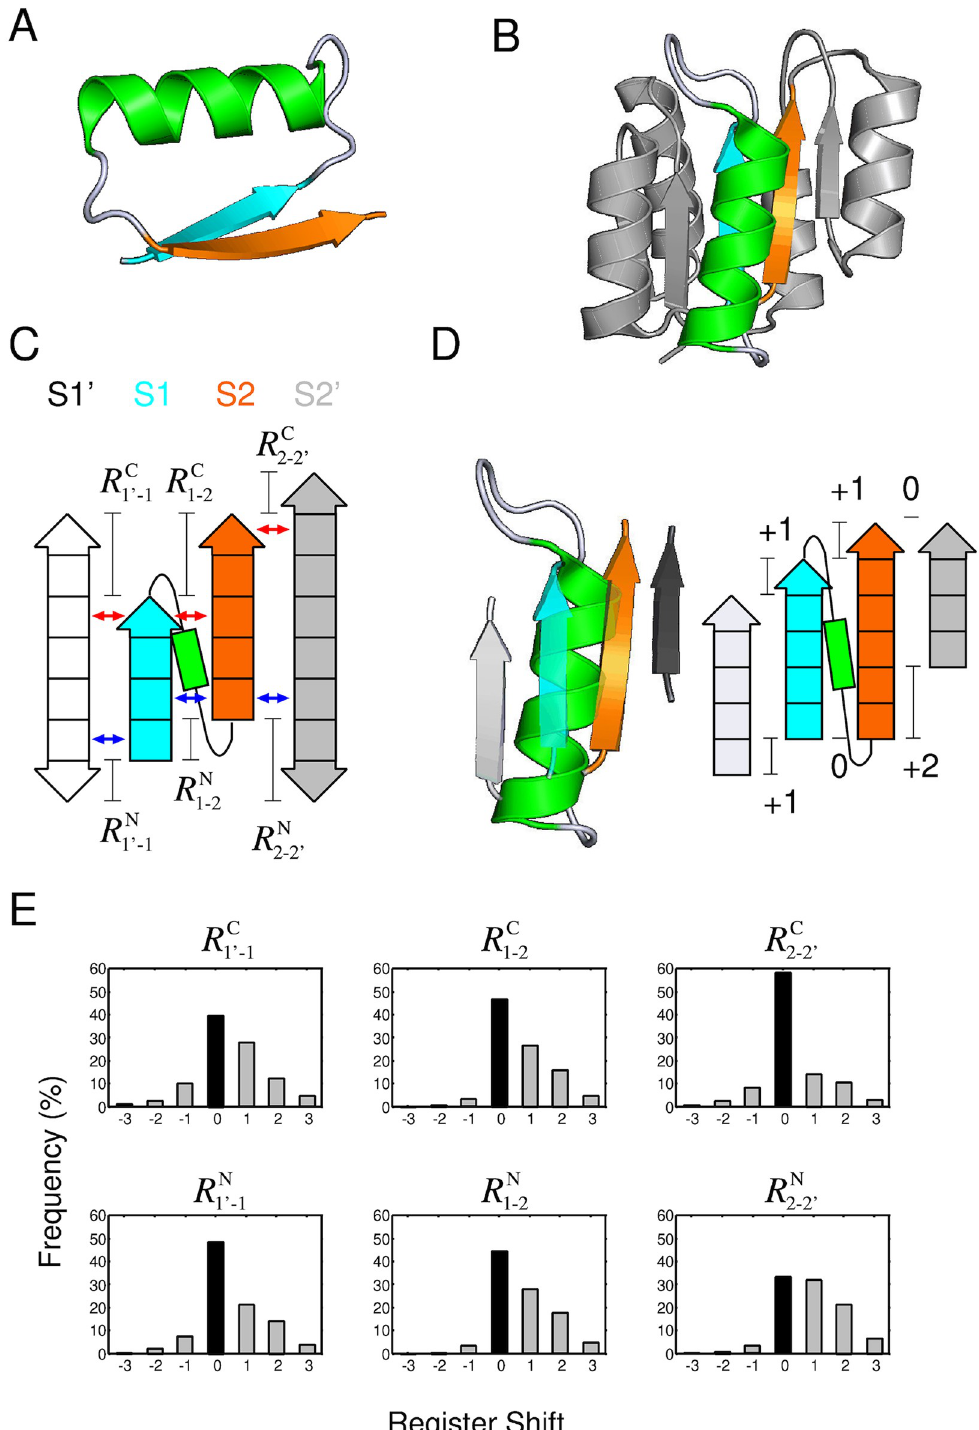
Fig 1. The six-type register shifts for βαβ -motifs, and the preferences in naturally occurring protein structures. (A) A βαβ -motif structure. A βαβ -motif is composed of two β -strands joined by an α -helix and forms a packing structure of the α - helix on the paired strands. The first and second strands are respectively colored in cyan and orange, and the α -helix is colored in green. (B) A naturally occurring protein structure containing βαβ -motifs (the response regulator Spo0F, PDB ID: 1peyA). In the structure, one of the βαβ -motifs is shown in colors. (C) A graphical explanation of the register